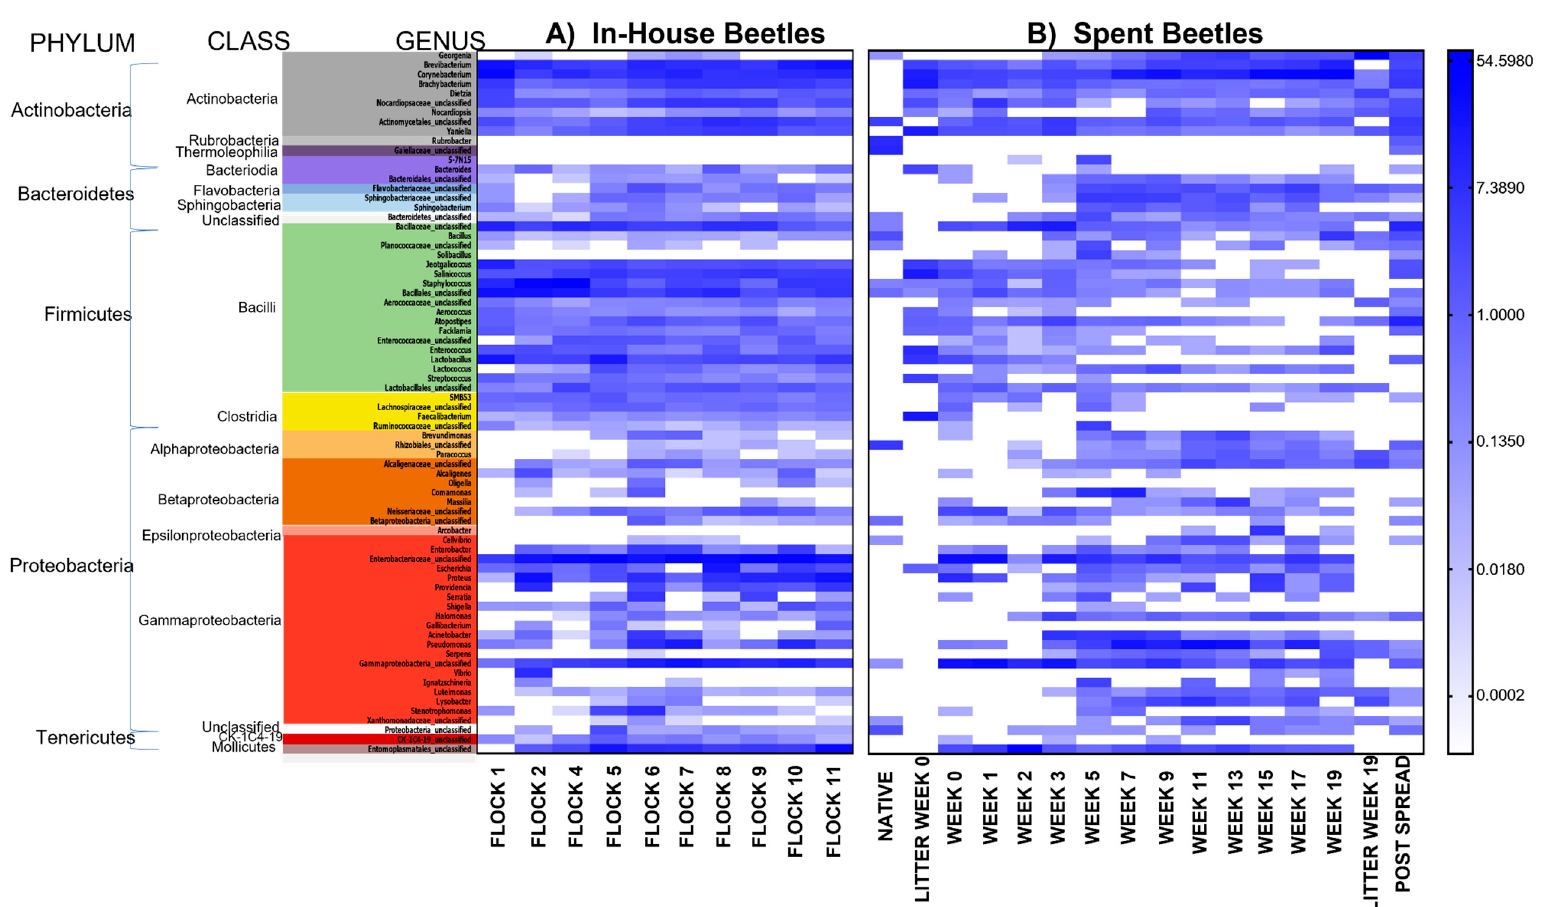
Figure 4. Heat map of natural log-transformed quantity of identified genera sequences (unweighted) in the LM beetles from the ( A ) In-House (grouped by class) collected during the flock rotations and ( B ) pastureland prior to deposition of the spent litter (native), samples of the Spent litter at the time of deposition into the pastureland and just prior to spreading (litter week 0 and litter week 19, respectively) and the soil/litter combination after spreading onto the pastureland (Post Spread); and the beetles collected from that litter over the 19 weeks of deposition (week 0 through week 19). n = 8 composite samples/Flock and 1 composite sample/Week.